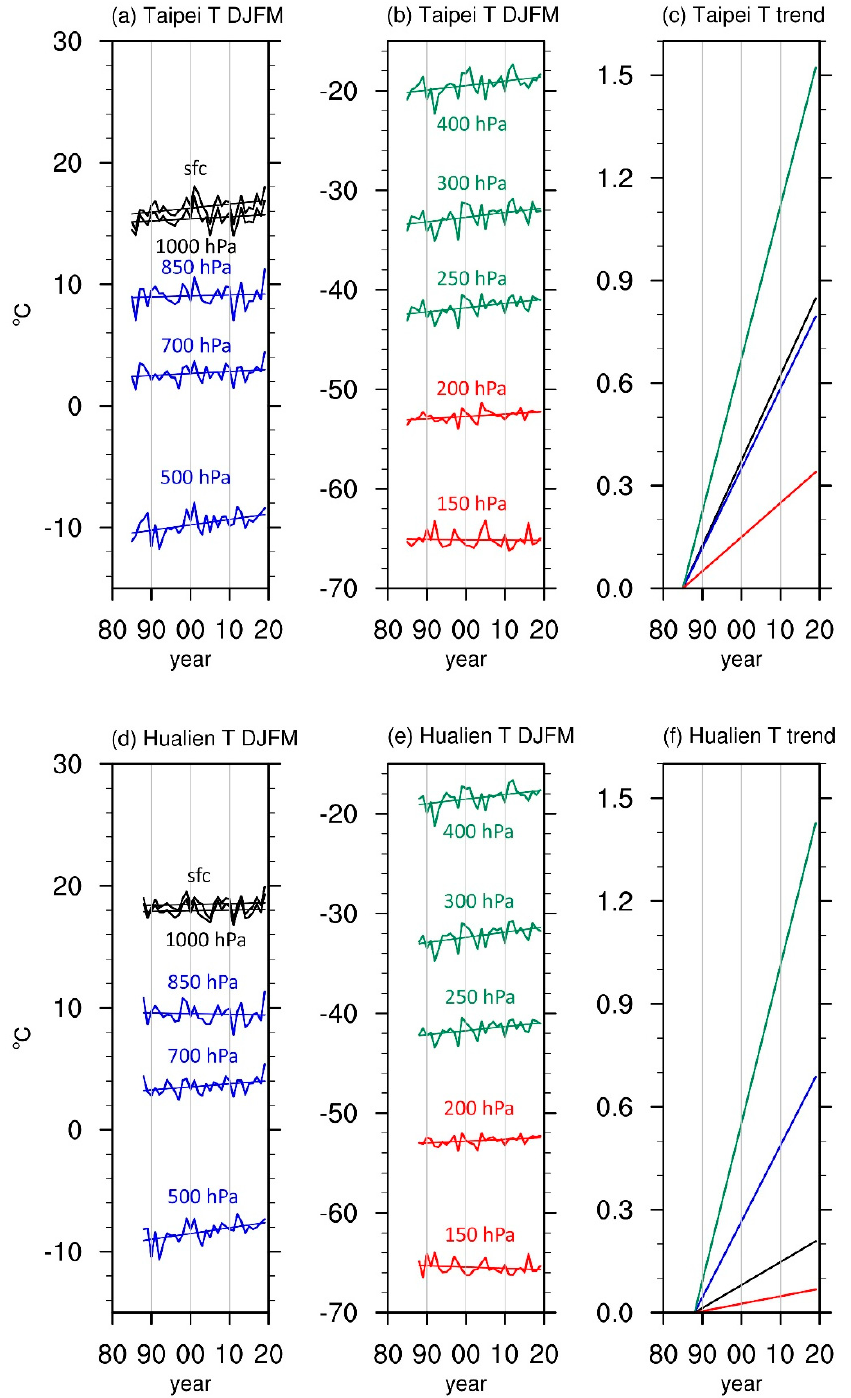
Figure 6. Same as Figure 5 but for the mean temperature from December to next March (DJFM) defined by [17].